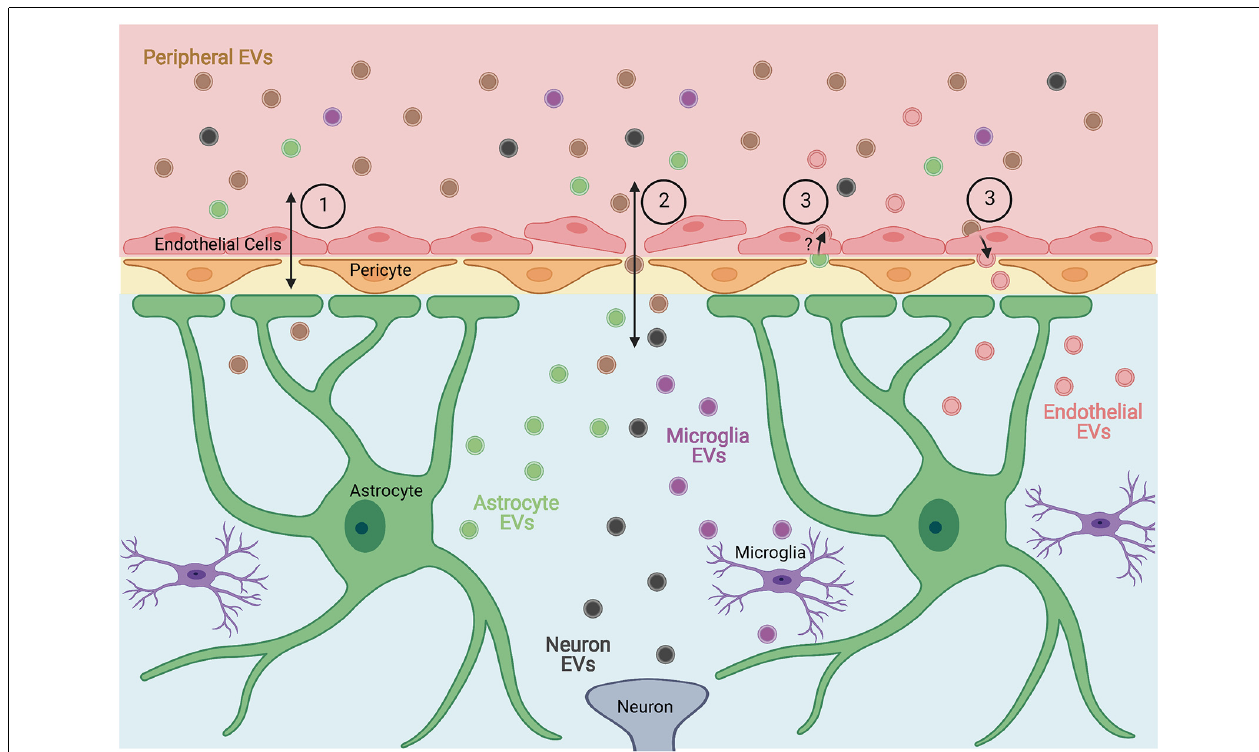
FIGURE 1 | Proposed mechanisms by which extracellular vesicles (EVs) cross the blood-brain barrier (BBB). EVs, or their contents, can enter or exit the brain through (1) receptor-mediated or adsorptive transcytosis, (2) breakdown of the BBB allowing for direct passage between endothelial cells, and (3) entry into endothelial cells and subsequent alteration of endothelial EVs. Figure created with